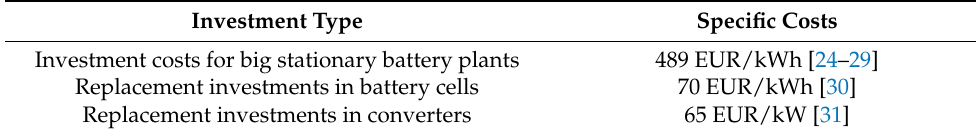
Table 7. Specific investment costs of BSS projects, battery cells and converters.